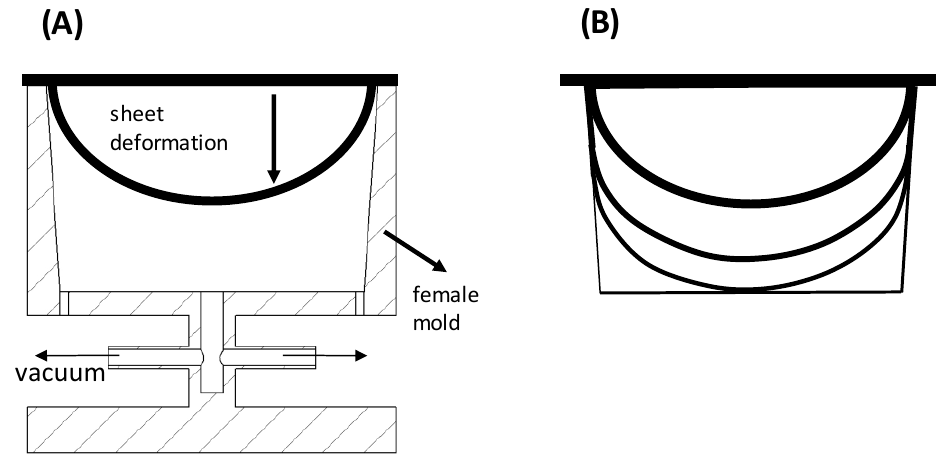
Figure 1. Thermoforming process and optimization. Thermoforming phases: ( A ) sheet; ( B ) heating; ( C ) shaping; ( D ) cooling; ( E ) final part. Optimization steps: ( i ) part properties; ( ii ) cooling effects; ( iii ) final part thickness distribution; ( iv ) sheet thickness distribution.